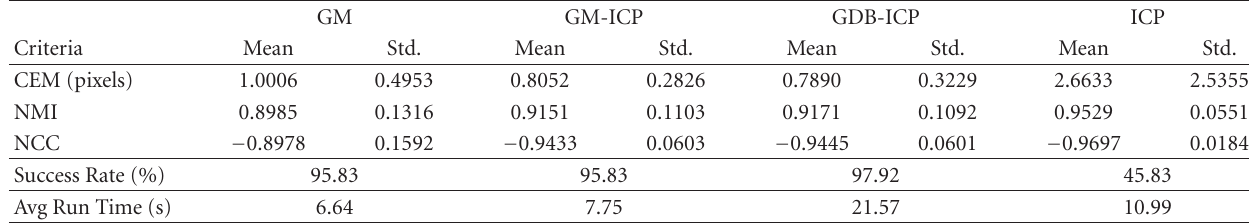
Table 2: The experiment results of GM-ICP in comparison with GDB-ICP and standard